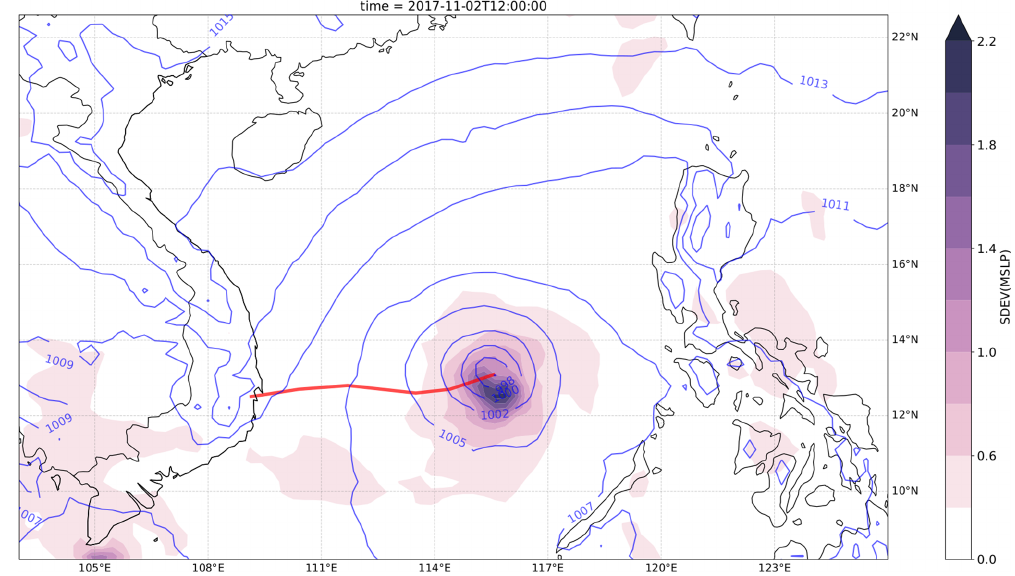
Figure 6. Ensemble mean sea level pressure (MSLP; violet contour lines) and ensemble spread (coloured contours) at a T L 639 resolution. The 0h forecast was initialized on 2 November at 12:00UTC. The observed track of Typhoon Damrey between 2 November at 12:00UTC and 4 November at 00:00 UTC (red line).